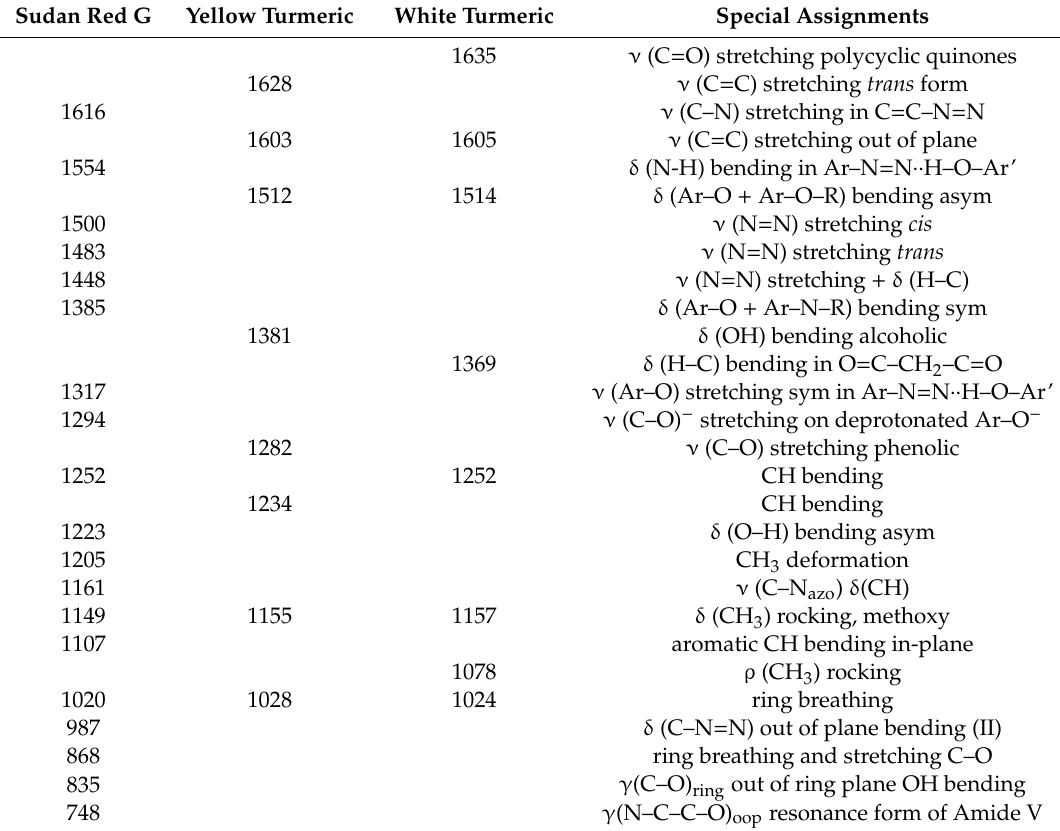
Table 1. Vibrational mode assignments for Sudan Red G, yellow turmeric, and white turmeric [36–53]. Sudan Red G Yellow Turmeric White Turmeric Special Assignments